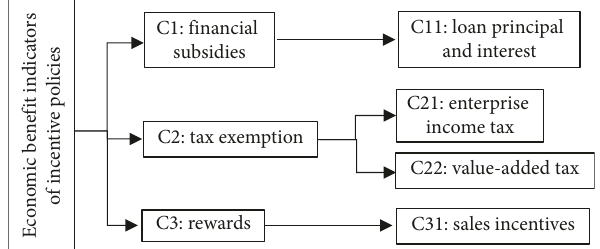
Figure 3: Economic benefits of incentive policies in prefabricated